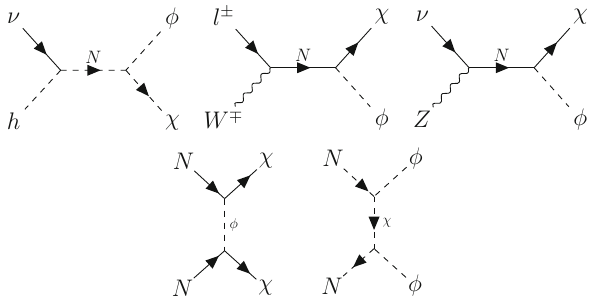
Fig. 2 Feynman diagrams for the DM production